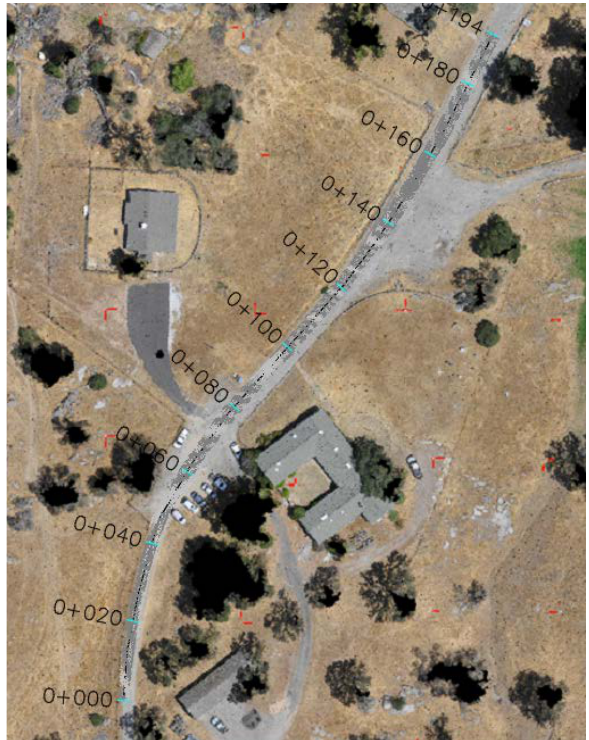
Figure 7. Road centerline and stations extracted from both point clouds for comparison.